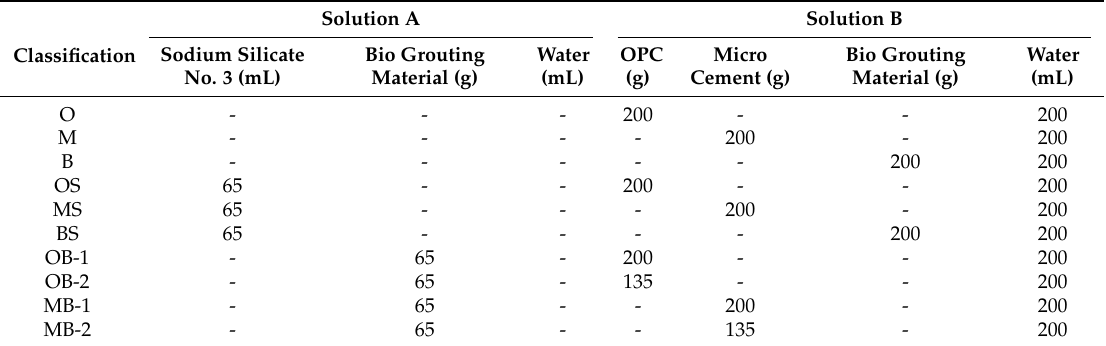
Table 1. Mixing ratios for uniaxial compressive strength test specimens for grouting materials.